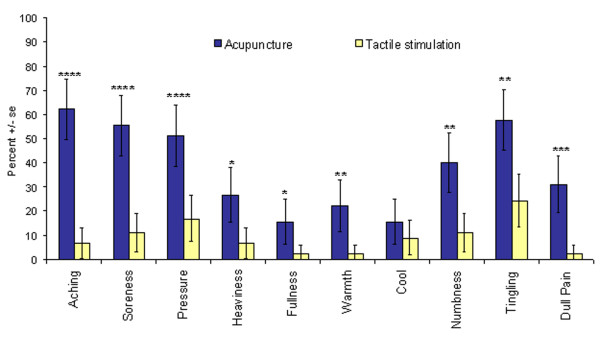
Comparison of the frequency of different sensations between acupuncture and tactile stimulation. When grouped across all acupoints (N = 45), virtually every sensation demonstrated a significant difference in frequency of experience between acupuncture and tactile stimulation control. In acupuncture, aching was the most frequent sensation, followed by soreness, pressure, tingling, numbness and dull pain. Tingling was the most common sensation in tactile stimulation. Error bars based on 95% Confidence Interval. Fisher's exact test: *p < 0.05, **p < 0.01, ***p < 0.001, ****p < 0.0001. For more details on data refer to Table 2.